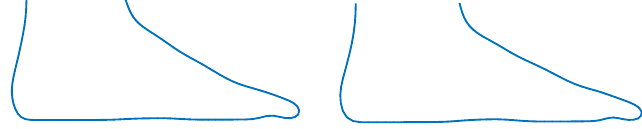
Figure 10. Mean shapes of contours for men ( left ) and women ( right